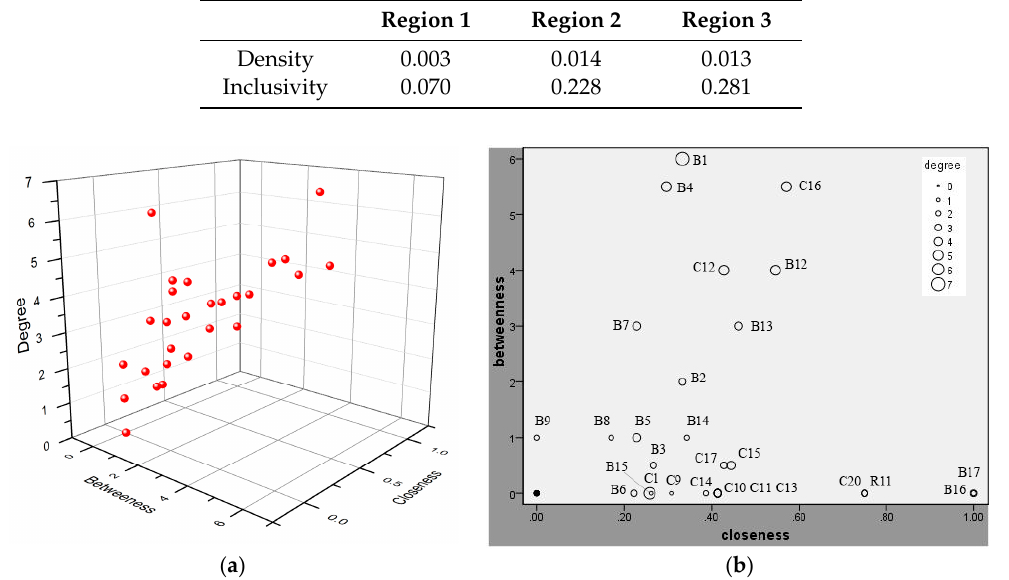
Figure 3. ( a ) Scatter plot and ( b ) bubble plot of node-scale CNA measures (degree, betweenness, and closeness). Table 3. CNA measures of global visibility